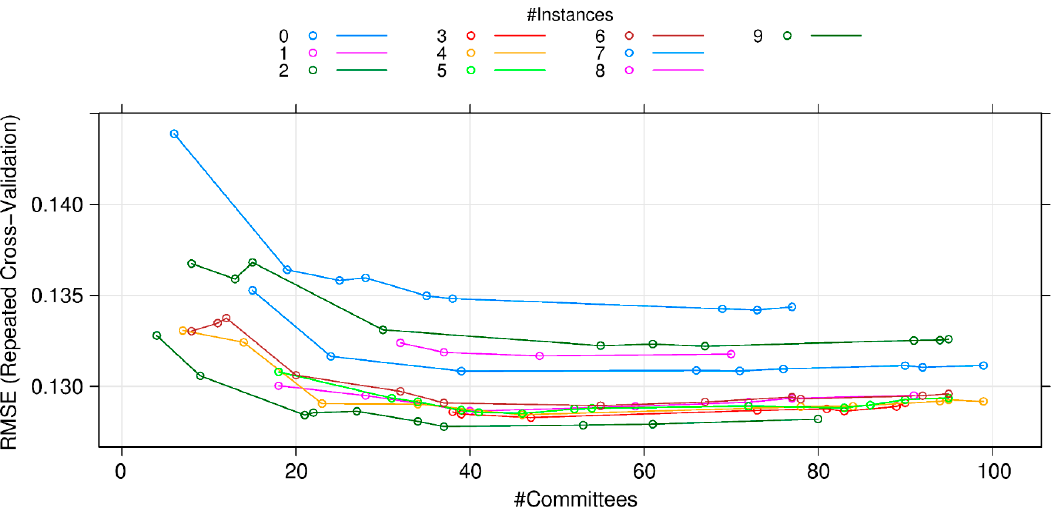
Figure 10. Performance of the cubist model in predicting ilmenite content.